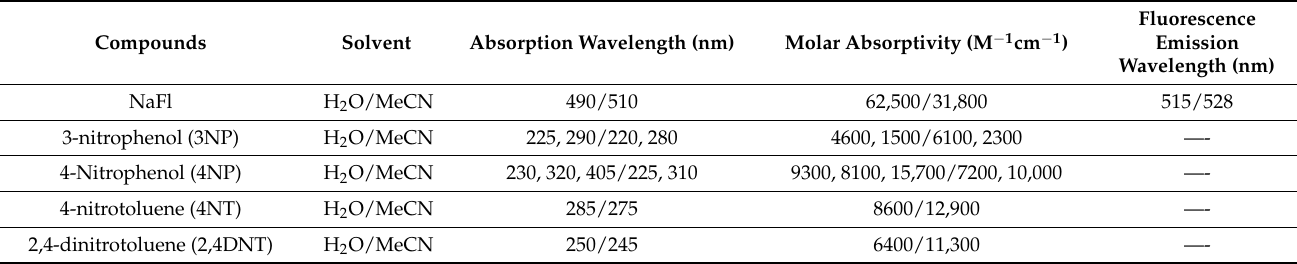
Table 1. Absorption and fluorescence emission maxima and the molar extinction coefficient of all compounds in water and